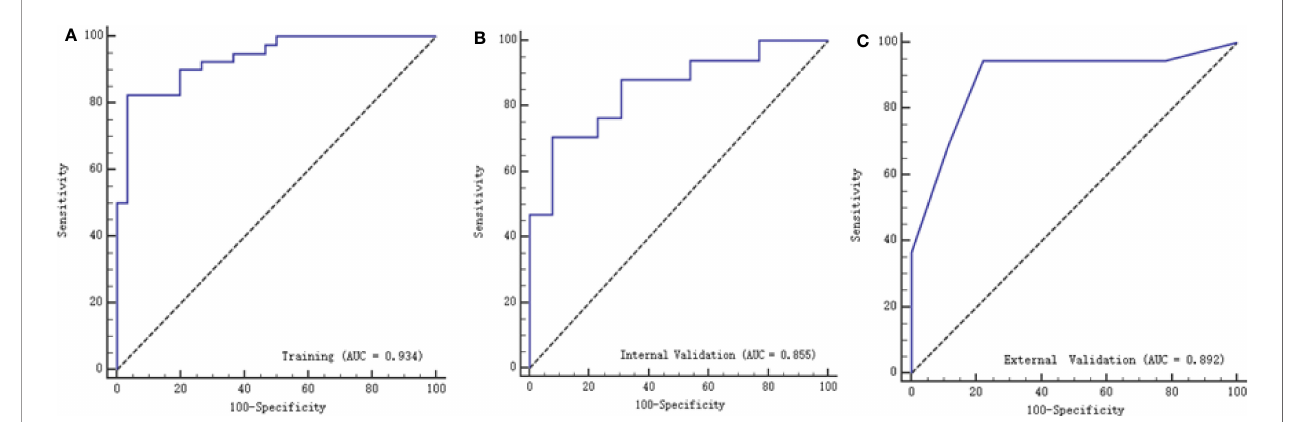
FIGURE 5 | ROC curves of texture features with the training, internal validation and external validation cohorts. (A) represents the training group with AUC of 0.934, (B) represents the internal validation group with AUC of 0.855, while (C) represents with external validation group with AUC of 0.892.